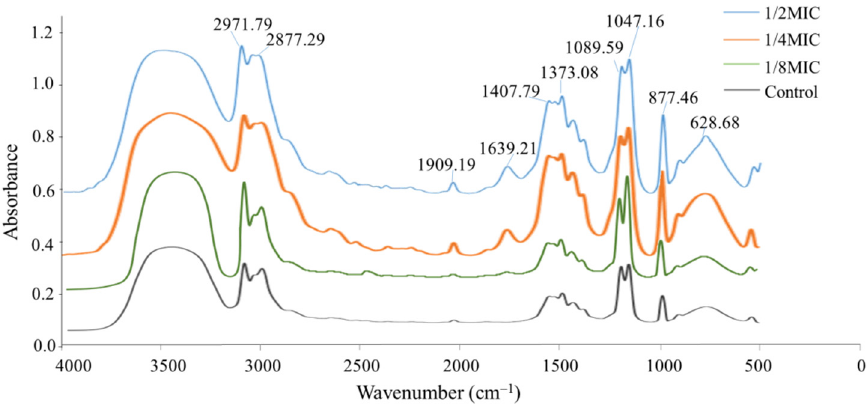
Figure 3. FTIR spectra of Pcc S1 treated by RTMBE. Cells treated with the same volume of phosphate-buffered saline were used as the control.